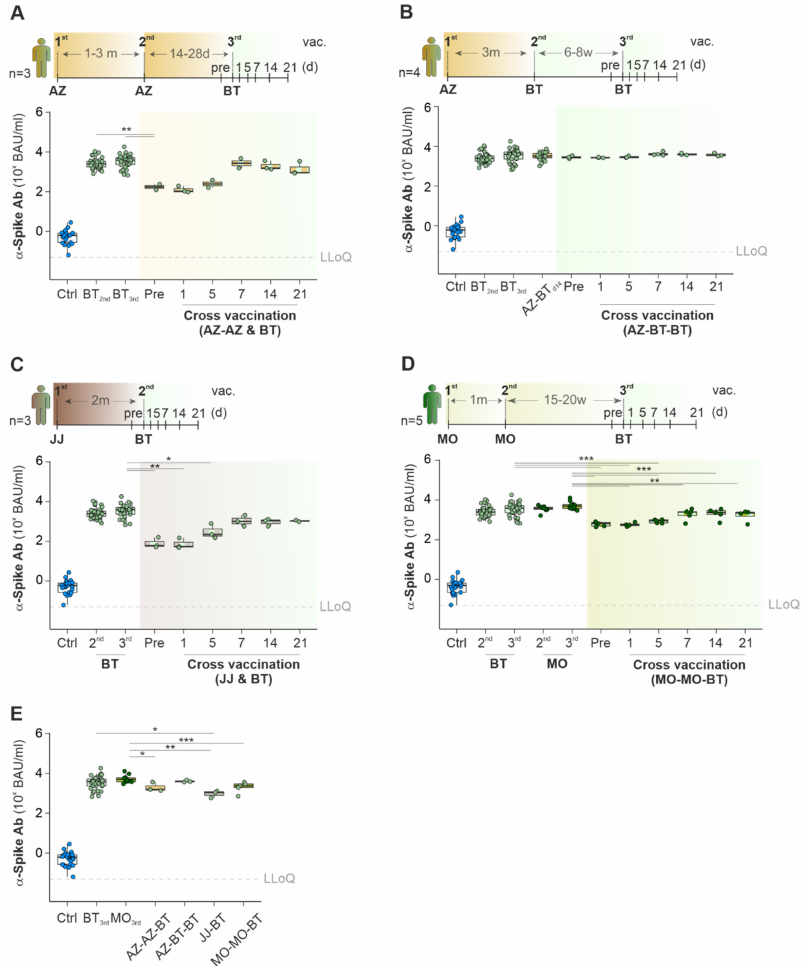
Figure 4. Comparative analysis of Ab titers against Wuhan SARS-CoV-2 Spike-protein in vaccination regimens with multiple vaccines. ( A – E ) Vaccination scheme (top) and concentrations of α -Spike-Ab over time (bottom) in cohorts vaccinated with various combinations (as indicated by the scheme) of AZ-AZ-BT ( A ), AZ-BT-BT ( B ), JJ-BT ( C ), and MO-MO-BT ( D ). ( E ) Comparison between the various vaccination schemes; LLoQ, Lower Level of Quantification; Man–Whitney U test, unadjusted p